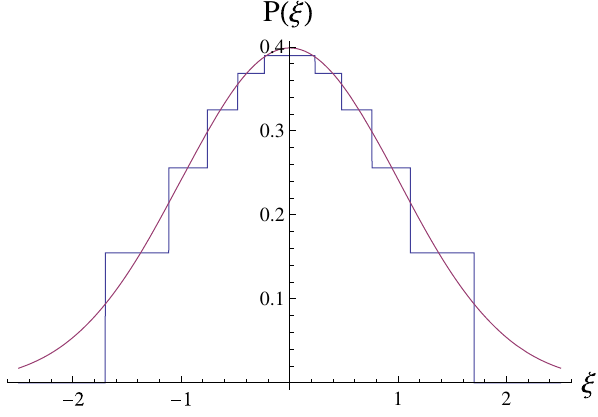
FIG. 2. Oscillator ground state for N ¼ 11 worlds. The steps of the stepped blue curve occur at the values q ¼ ξ 1 ; ξ 2 ; … ; ξ 11 , corresponding to the stationary world configurations x 1 ; x 2 ; … ; x 11 via Eq. (41). The height of the step between ξ n − 1 , which from Eq. (21) is ξ ≔ N − 1 ð ξ − ξ and ξ is P n þ 1 N ð n Þ n þ 1 n Þ expected to approximate the quantum ground-state distribution for a one-dimensional oscillator, P Ψ ð ξ Þ ¼ ð 2 π Þ − 1 = 2 e − ξ 2 = 2 , for 0 large N . The latter distribution is plotted for comparison (smooth magenta curve). All quantities are